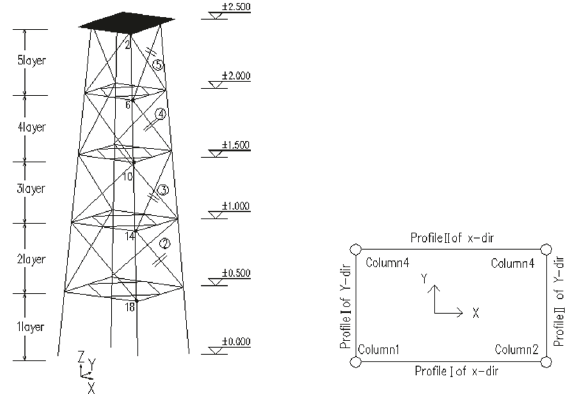
Figure 3: A numerical model of offshore